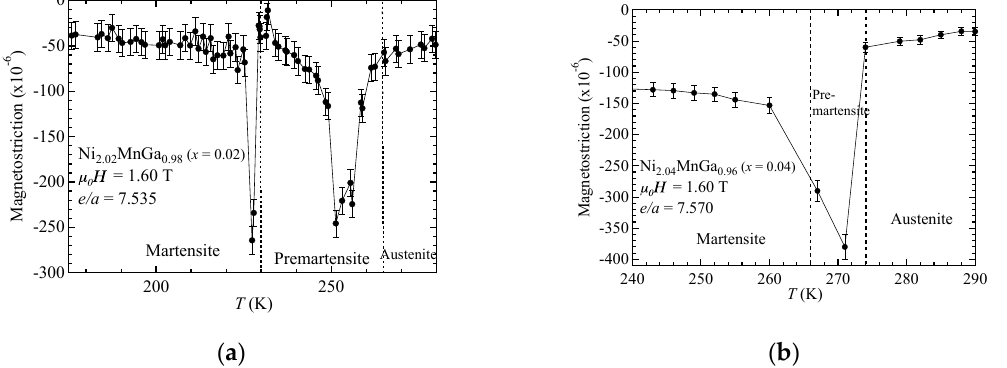
Figure 8. The temperature dependencies of the magnetostriction for ( a ) x = 0.02 and ( b ) x = 0.04.